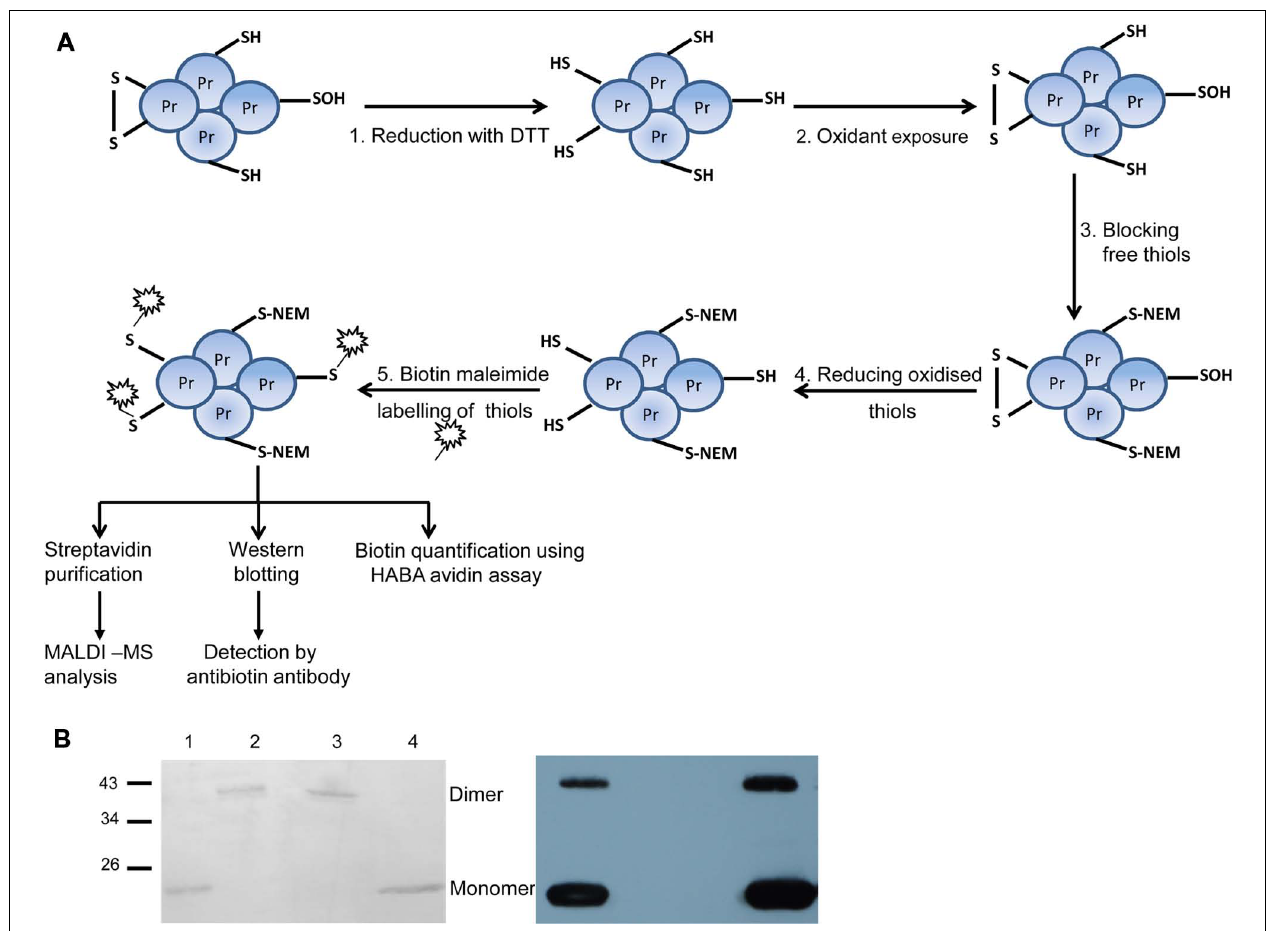
FIGURE 2 | Overview of the procedure for labeling reversibly oxidized cysteines and test experiment with 2-Cys Prx. (A) Work flow used for identifying protein targets sensitive to low H 2 O 2 concentrations consisted of five steps: step 1 includes complete reduction of protein thiols using the artificial reductant DTT. Step 2: After desalting to remove excess DTT, proteins were exposed to H 2 O 2 for 5 min. In step 3, free thiol groups were blocked using NEM under denaturing conditions. Reversibly oxidized thiols were reduced with DTT in step 4.The newly exposed thiol groups were labeled using the thiol specific reagent biotin maleimide in step 5. As a control reaction, proteins were not subjected to oxidation (step 2) while all other